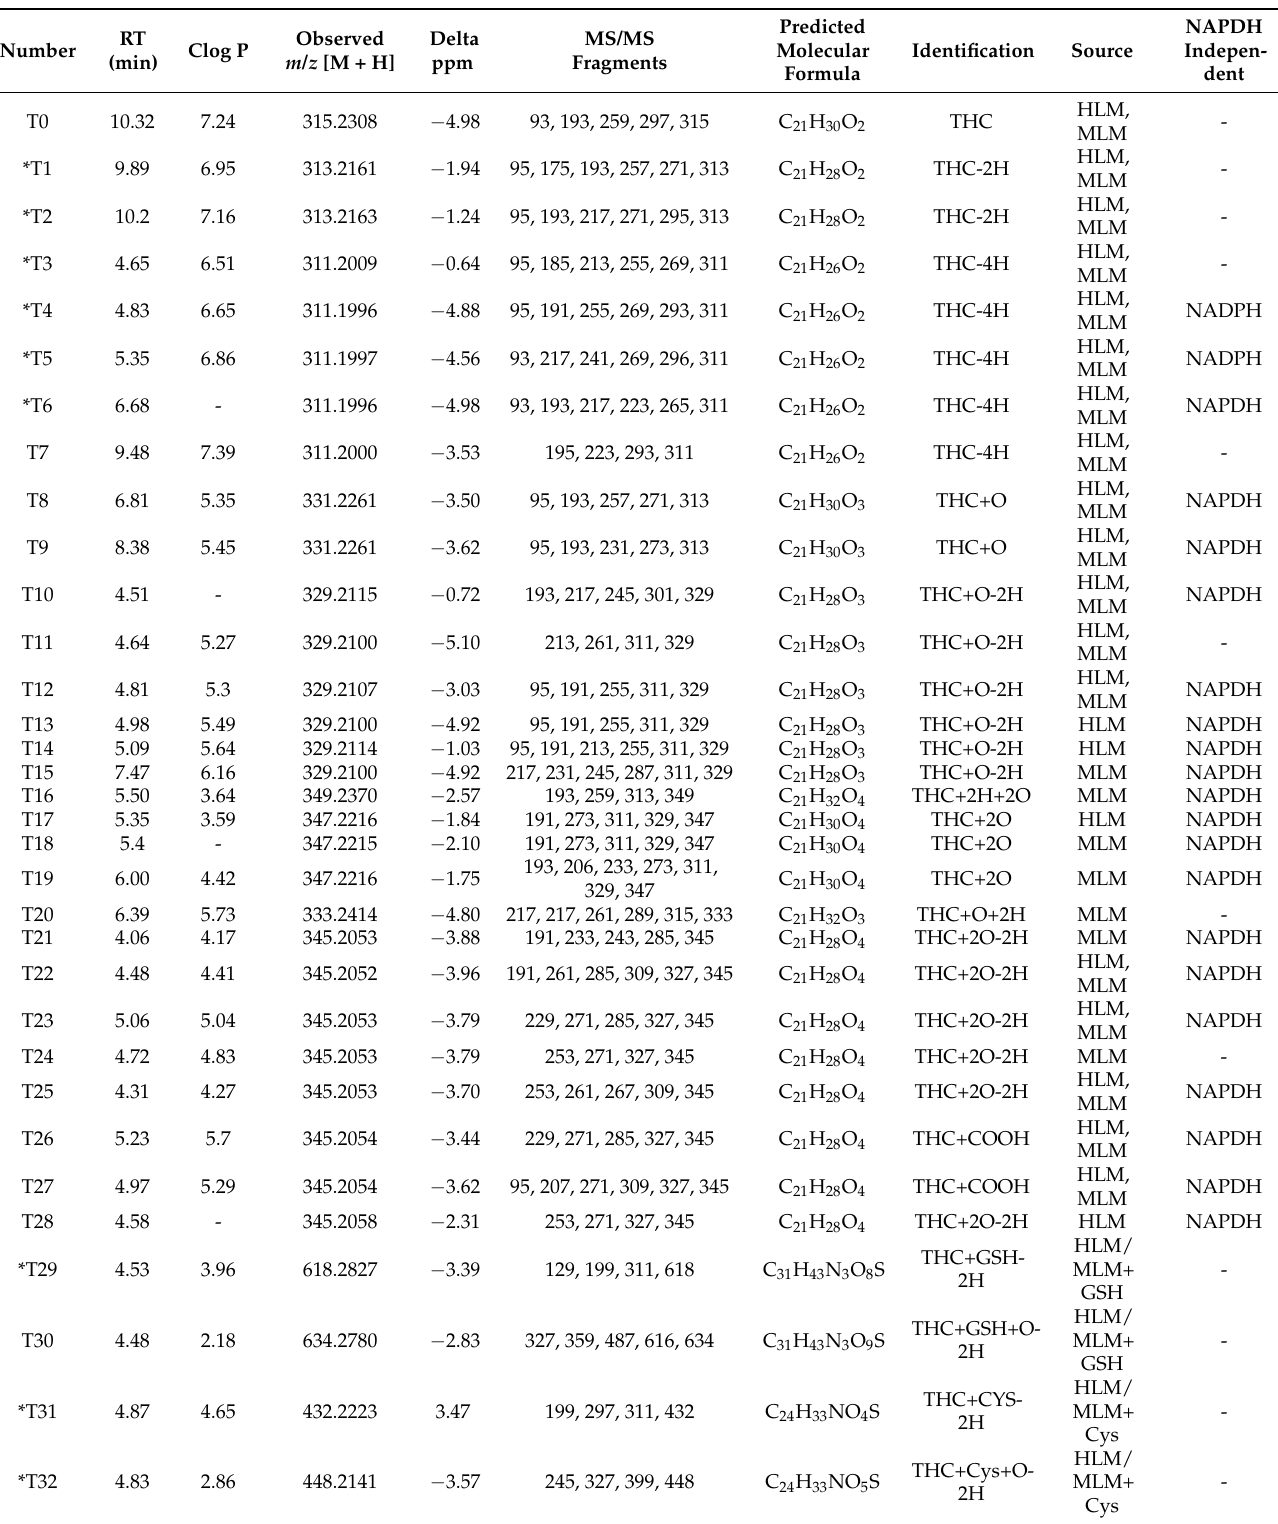
Table 1. Summary of THC metabolites produced with metabolisms in